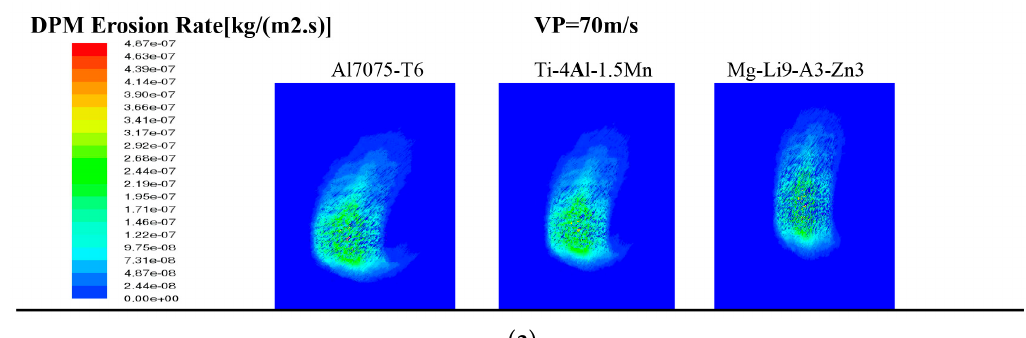
Figure 8. Accretion rate curves of three materials at different impact speeds at 0° angle of attack: ( a ) V P = 70 m/s; ( b ) V P = 150 m/s; ( c ) V P = 220 m/s. Table 6. Average accretion rates of the three material at different impact speeds.